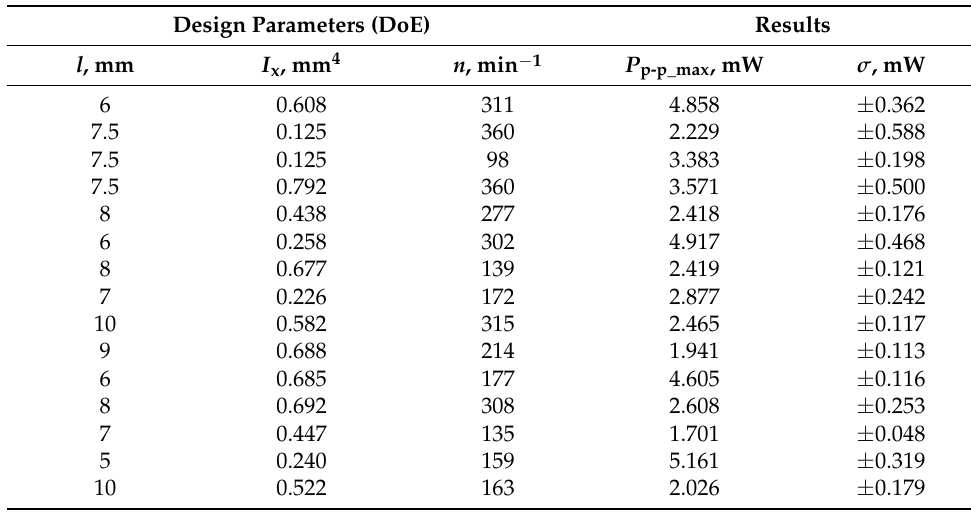
Figure 6. Peak-to-peak voltage used to calculate the maximal PEH power output P p-p_max . Table 4. DoE design parameters values and resulting experimentally obtained maximal power values P p-p_max with their standard deviations σ